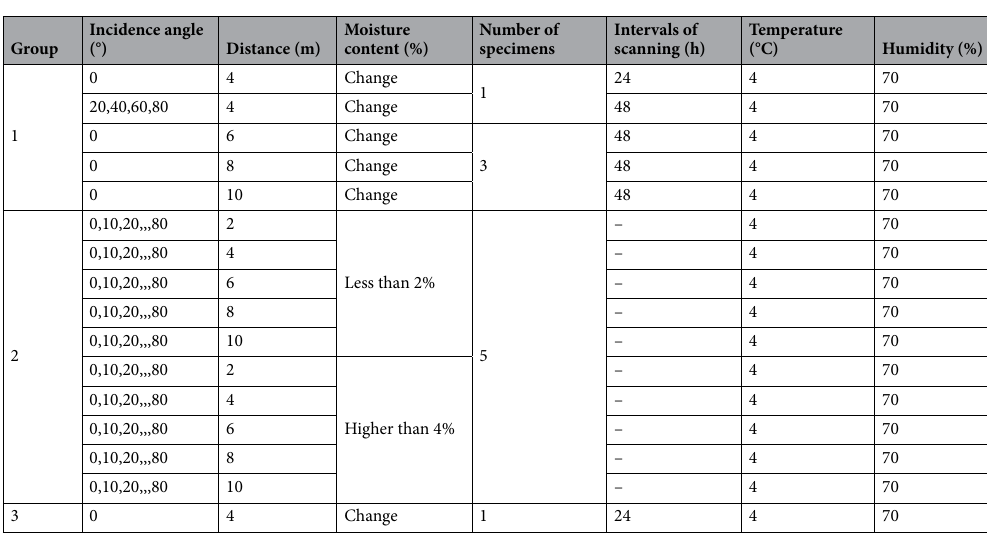
Table 2. Design of monitoring method of the total three experiments.